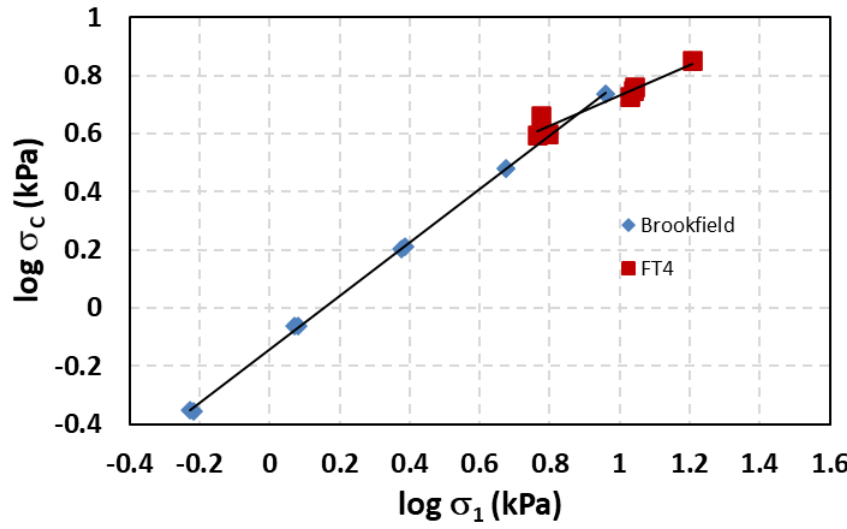
Figure 9. Flow function of calcium phosphate.